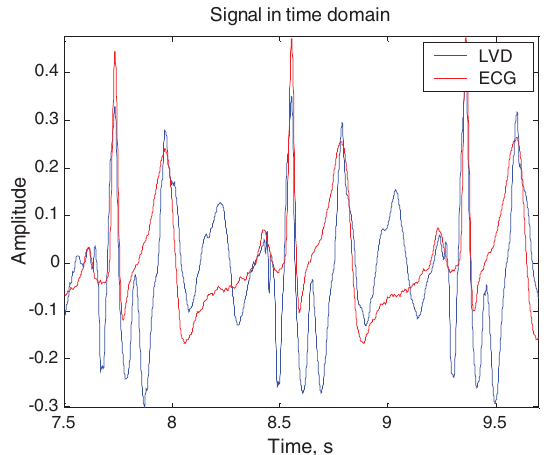
Fig.2. LVDsignalsandECGsignalsinthetimedomain.Thesignals weremeasuredsimultaneously,butforpurposeofgraphing,theLVD was shifted forward by 100ms. With this delay, correlations emerge between the electrical signal and the vibrational signal, as well as additional signals in the vibrational signal not present in the